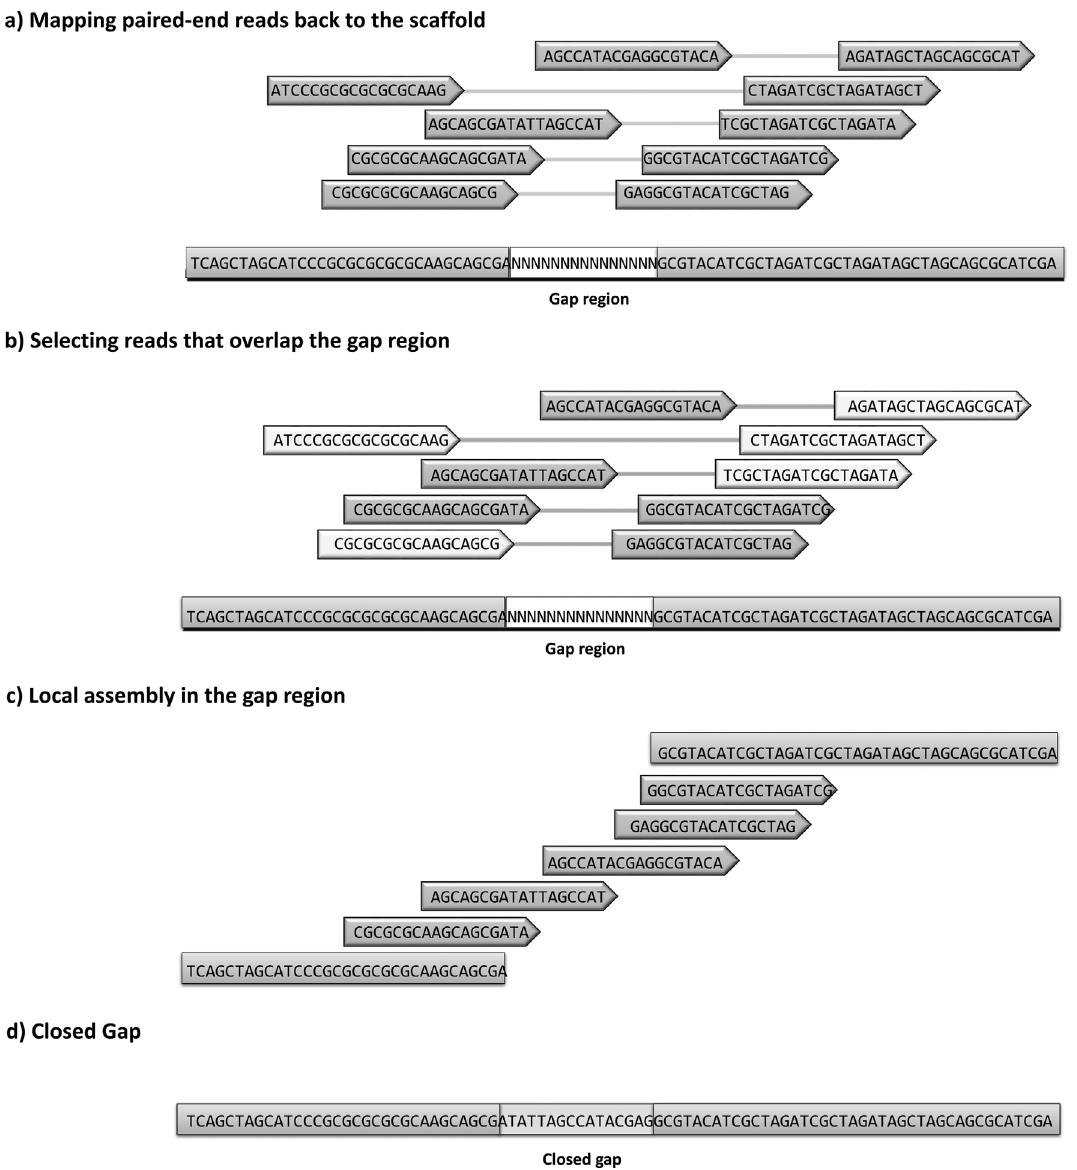
Figure 3 - Example of a gap-closing approach using paired-end reads. (a) Taking as example a scaffold constituted by two contigs joined by an assembly gap (a run of `N’s) by remapping the reads back to the contigs (b) it is possible to identify reads that have at least one of the mates in the gap region. Finally, (c) the reads identified inside the gap can be de novo assembled to fill the region, resulting in a (d) closed